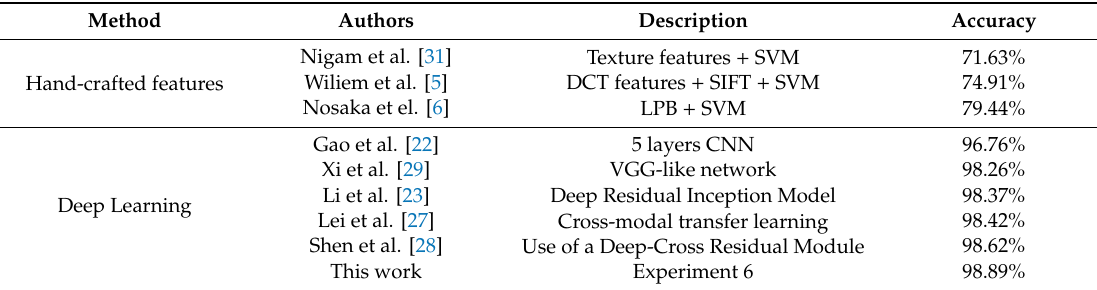
Table 2. Comparative study for the ICPR 2016